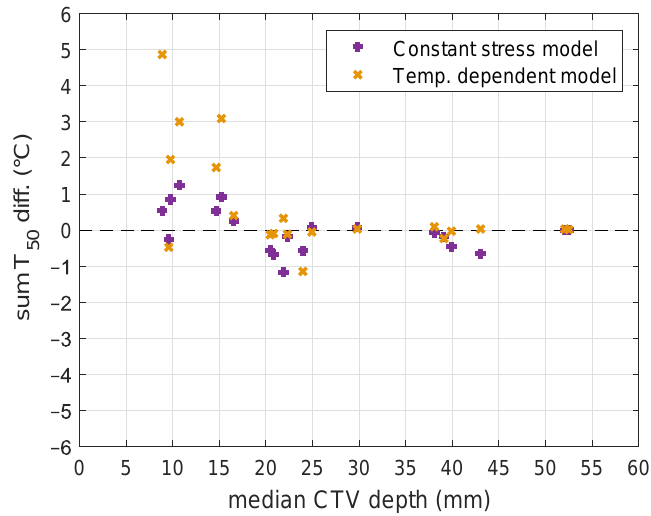
Figure 5. T50 mean temperature gradients for water bolus change from 20 °C to 40 °C and heat transfer coefficient of h = 292 W m − 2 K − 1 as function of median CTV depths (depths of half of the CTV volumes) in all 20 patients for constant stress model and temperature-dependent model. Note that the T50 values of the two temperature models overlap for some median CTV depths.